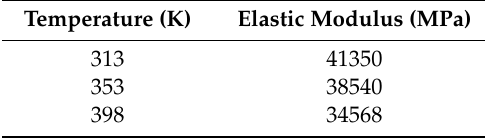
Figure 5. Uniaxial tensile test finite element numerical calculation model: ( a ) two-dimensional diagram and ( b ) three-dimensional diagram.